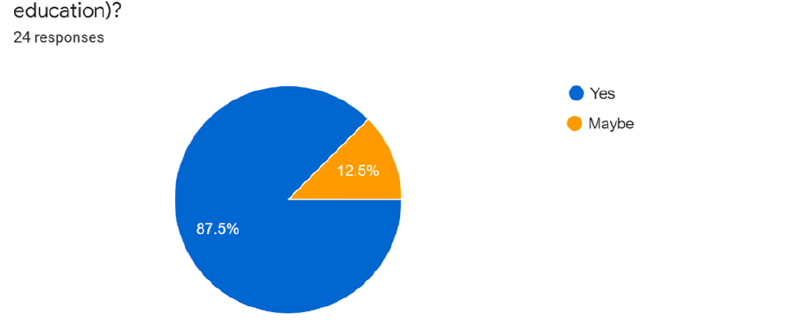
Figure 11. VoRtex test results from Google Forms report. VW in education.